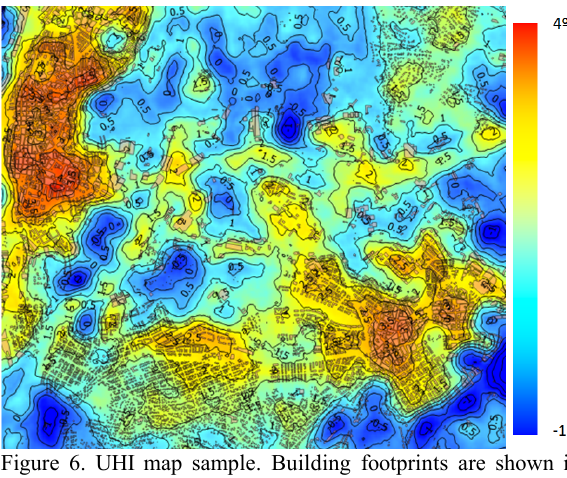
Figure 6. UHI map sample. Building footprints are shown in transparency, isothermal contour lines are drawn in black every